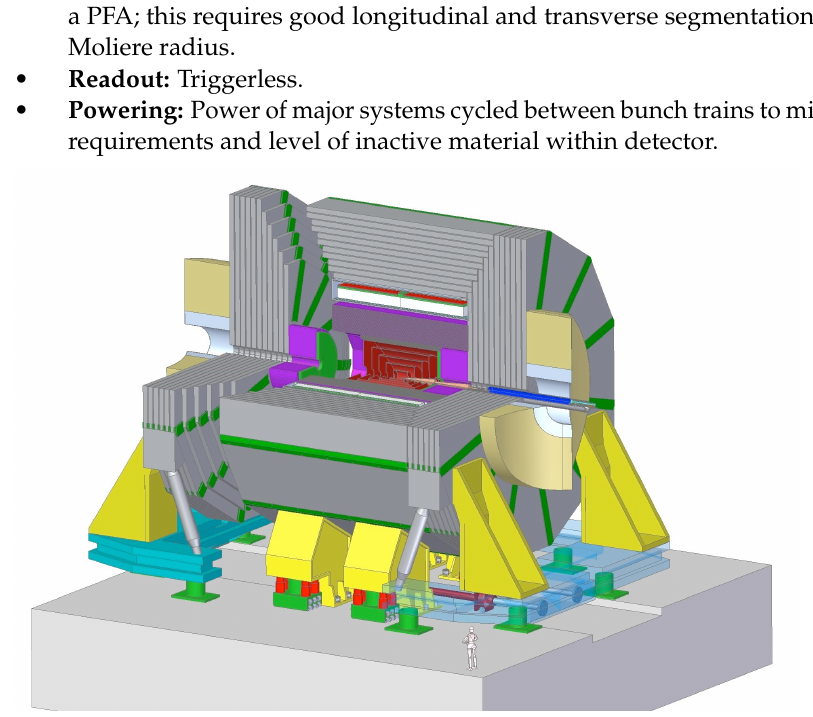
Figure 2. SiD on its platform, showing tracking ( red ), ECAL ( light green ), HCAL ( violet ) and reconfigured dodecagonal iron